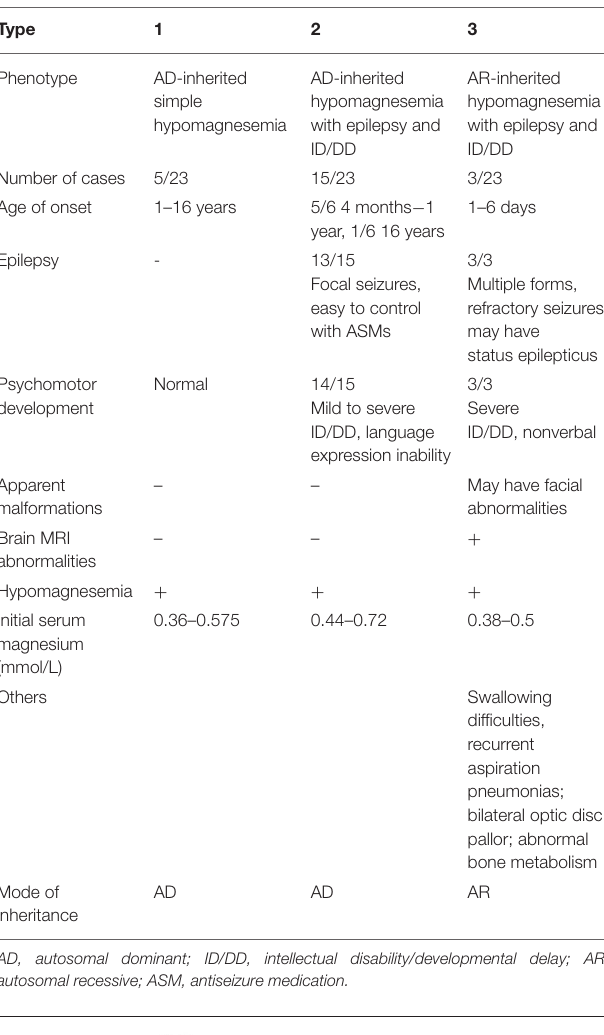
DUF21 domain, two CBS domains, and one CNBH (Cyclic Nucleotide-Binding Homology) domain (8). Variants